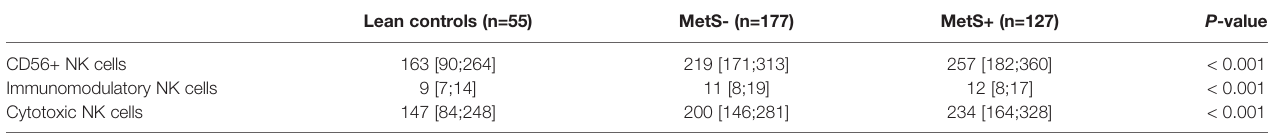
MetS-, morbidly obese patients without metabolic syndrome; MetS+, morbidly obese patients with metabolic syndrome; NK, natural killer. All absolute numbers are presented as median [interquartile range]. P-values are after correction for covariates using a binomial mixed regression model.